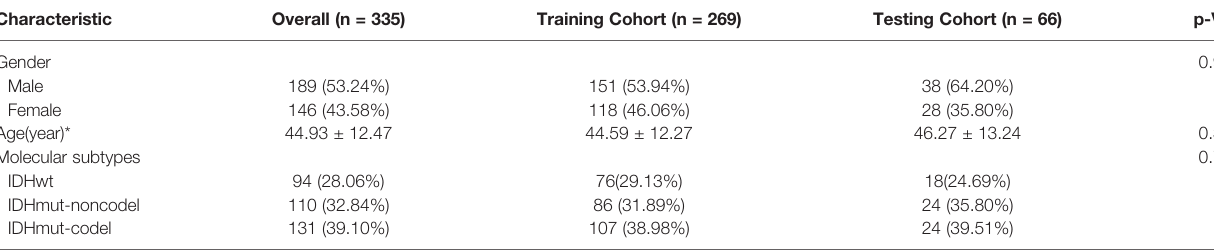
TABLE 1 | Distribution of patient characteristics in the training cohort and testing